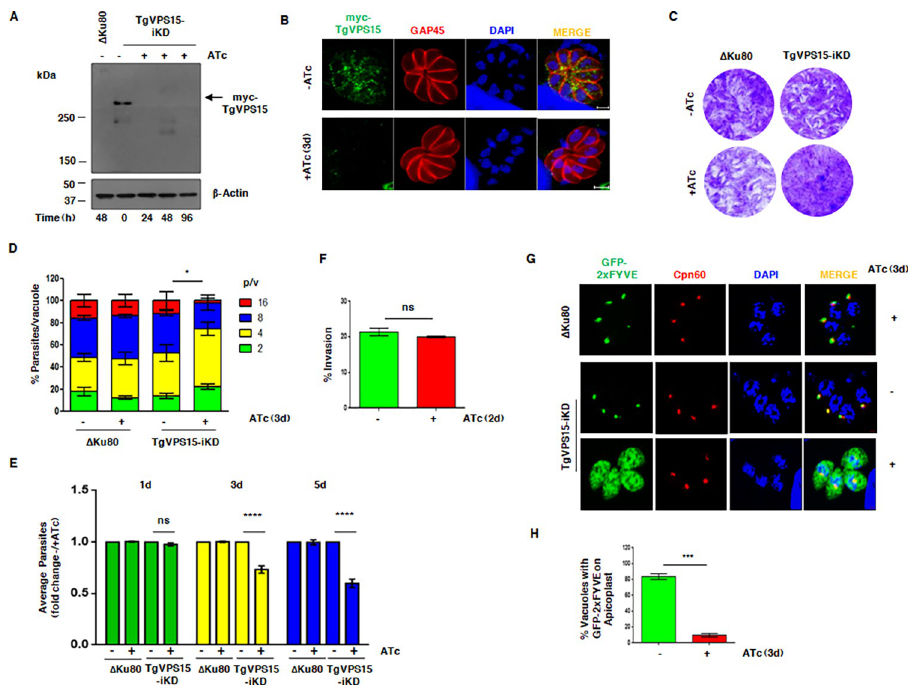
Fig 2. TgVPS15 regulates PI3P formation and is critical for parasite replication. A. Depletion of TgVPS15 in Toxoplasma gondii . TgVPS15-iKD parasites were treated with ATc for indicated duration followed by Western blotting of parasite lysate, which revealed that Myc-TgVPS15 migrates at an expected size and the addition of ATc resulted in its depletion. Δ Ku80 was used as a negative control. B. IFA was performed on TgVPS15-iKD parasites that were left untreated or treated with ATc for 72h or 3d using anti-myc and anti-GAP45 antibodies. C. Plaque assays were carried out by infecting HFF monolayer with Δ Ku80 or TgVPS15-iKD parasites in the presence or absence of ATc for 7 days (for quantitation please see Supp. S3B Fig). D. TgVPS15-iKD or Δ Ku80 parasites were preincubated in culture medium for 48h or 2d with (+) or without (-) ATc and were subsequently allowed to invade fresh HFFs in the presence or absence of ATc and the number of parasites per vacuole was determined after 24h or 1d. Data represent Mean ± SE, n = 3 and at least 200 vacuoles were counted for each condition (n = 3, ��� P < 0.001 4 p/v, �� P < 0.01 8 p/v, � P < 0.05 16 p/v ANOVA, ns-not significant). E. TgVPS15-iKD or Δ Ku80 parasites were treated with ATc for 1d, 3d or 5d and replication assay was performed as described in panel E and average intracellular parasites/vacuole present in each condition was determined. Fold change in average parasites upon ATc addition was determined (Mean ± SE, n = 3, ANOVA, ���� P < 0.0001; ns-not significant). F. Invasion assays were performed on TgVPS15-iKD parasites that were left untreated or treated with ATc. No significant change in invasion was observed (P > 0.05, t test, n = 2, ns-not significant). G. Δ Ku80/DD-GFP2xFYVE or TgVPS15-iKD/DD-GFP2xFYVE parasites that expressed GFP-2xFYVE domain infected HFF were left untreated (-) or treated (+) with ATc for 72h or 3d. Prior to fixation, Shield-1 was added for 30 minutes to stabilize the expression of GFP-2xFYVE, which was localized mainly to the apicoplast as revealed by IFA for Cpn60, an apicoplast protein. GFP-2xFYVE was found mainly in the cytoplasm of ATc-treated TgVPS15-iKD parasites. H. % vacuoles in which GFP-2xFYVE was found at the apicoplast was determined in IFAs for experiments reported in panel G (Mean ± SE, n = 3, ��� p < 0.001,